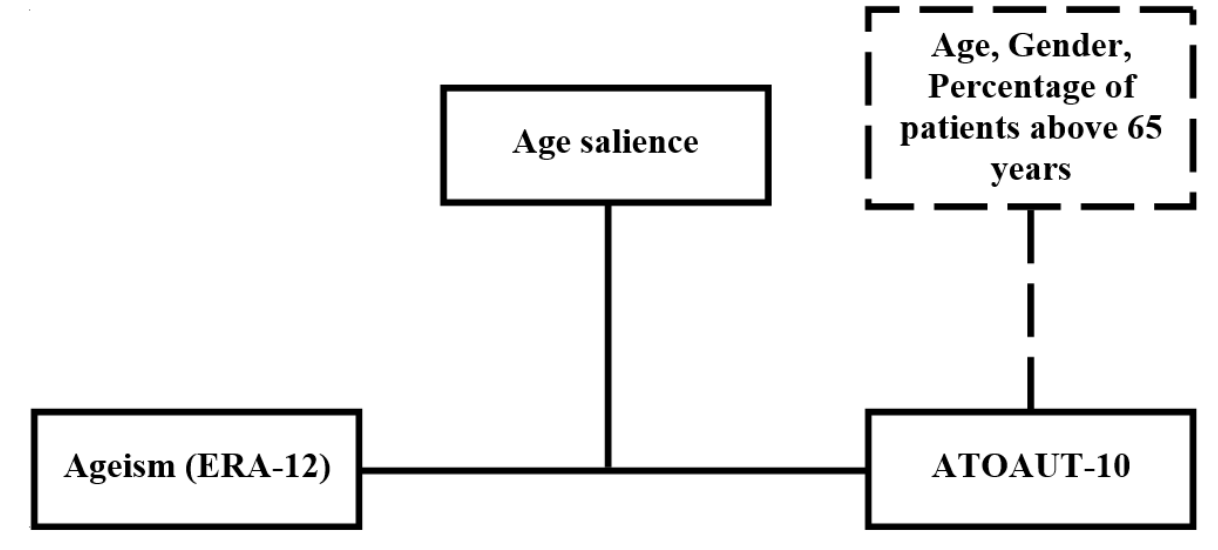
Figure 1. Assumed moderation model of age salience (young and old) on the correlation between ageism (measured by ERA-12) and attitudes towards older adults using technology (ATOAUT-10). Age, gender, and percentage of patients above 65 years were added to the model as covariates. ATOAUT: attitudes toward older adults using technology; ERA-12: Expectations Regarding Aging